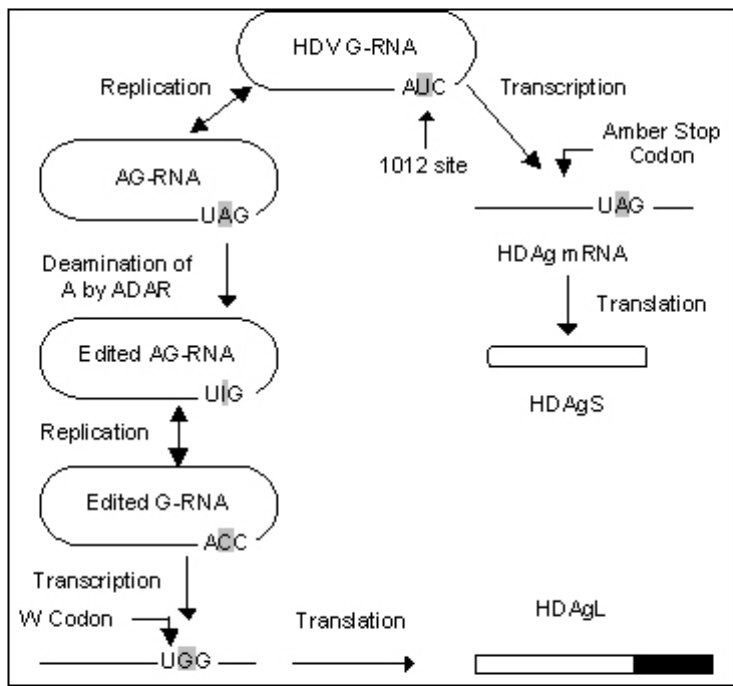
FIGURE 5 . ADAR activity on HDV RNA. (G-RNA: genomic RNA. AG-RNA: antigenomic RNA. W: tryptophan). During HDV replication, by the double-rolling circle mechanism, the G-RNA replicates to form AG-RNA and vice versa. Simultaneously, mRNA for HDAg is transcribed off the G-RNA. This mRNA is translated to form the protein referred to as HDAgS (short form). Later in the replication cycle, ADAR enzymes act on part of the AG-RNA molecules, causing deamination of A on the UAG stop codon I. Subsequent rounds of replication forms edited G-RNAs, which are then transcribed to mRNAs that have their UAG stop codons converted to UGG W codons, and hence having longer reading frames. Proteins translated from these edited mRNAs are longer compared to HDAgS, and are called HDAgL (long